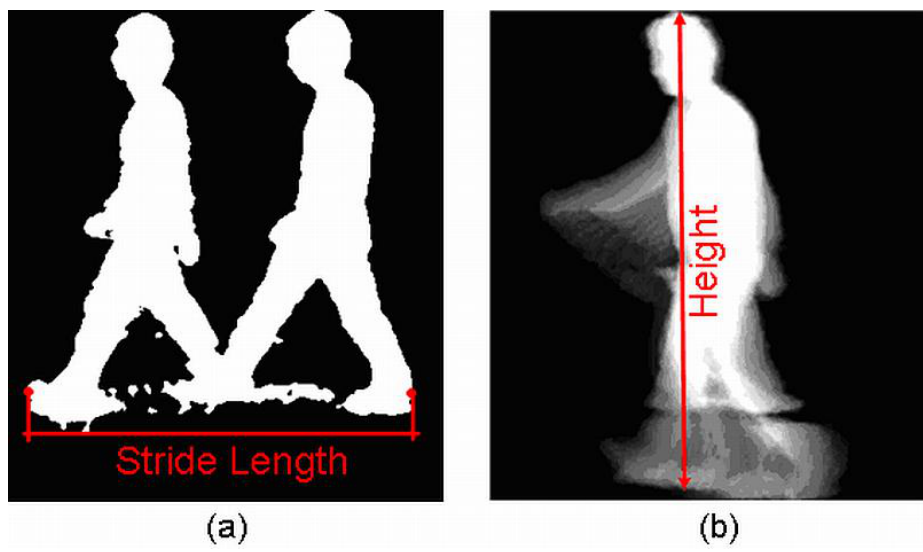
FIGURE 6. (a) Estimation of stride length, (b) gait energy image –